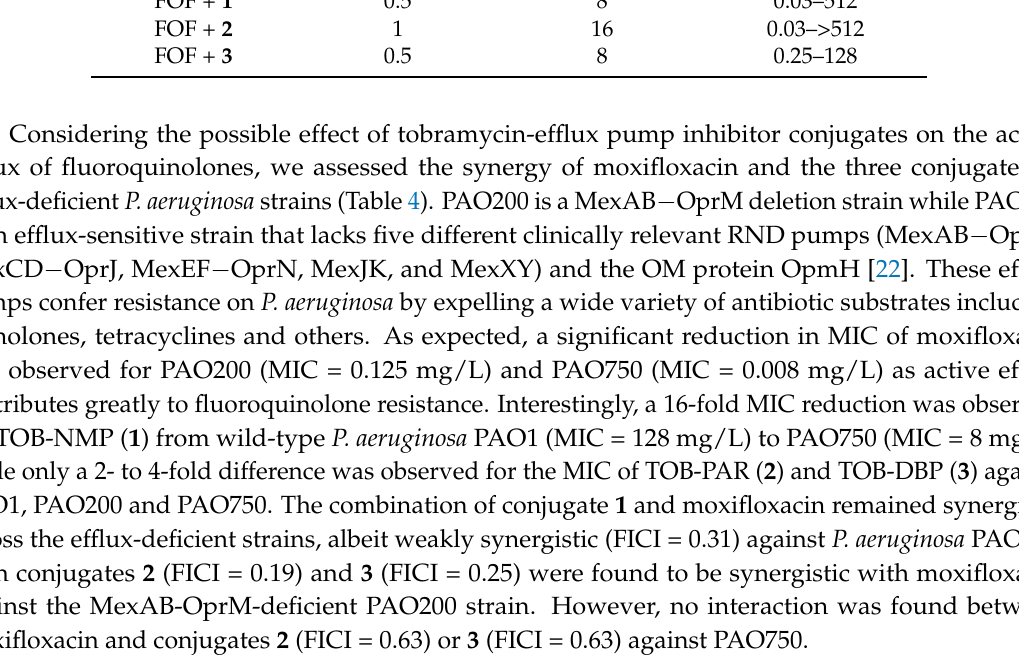
Table 4. In vitro activity of moxifloxacin (MOX), TOB-EPIs ( 1 , 2 and 3 ) and combinations of